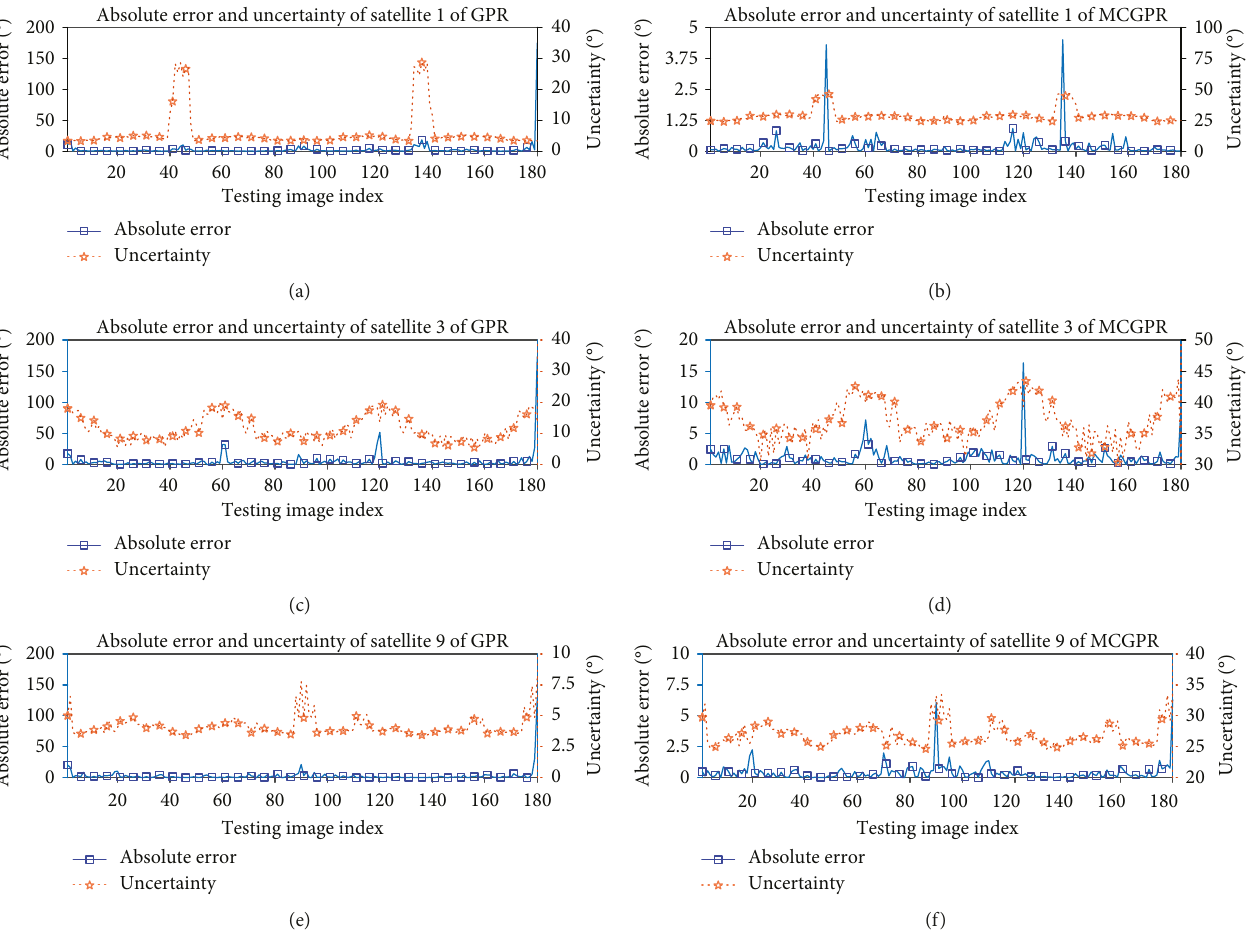
Figure 2: Uncertainty analysis results of three satellites on the 1D subset of BUAA-SID